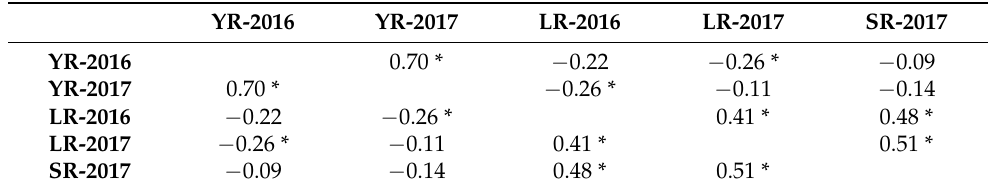
Table 2. Pearson correlations at significance level alpha = 0.05 (*) between yellow (YR), leaf (LR) and stem (SR) rust trials, in 2016 and 2017, under field conditions.